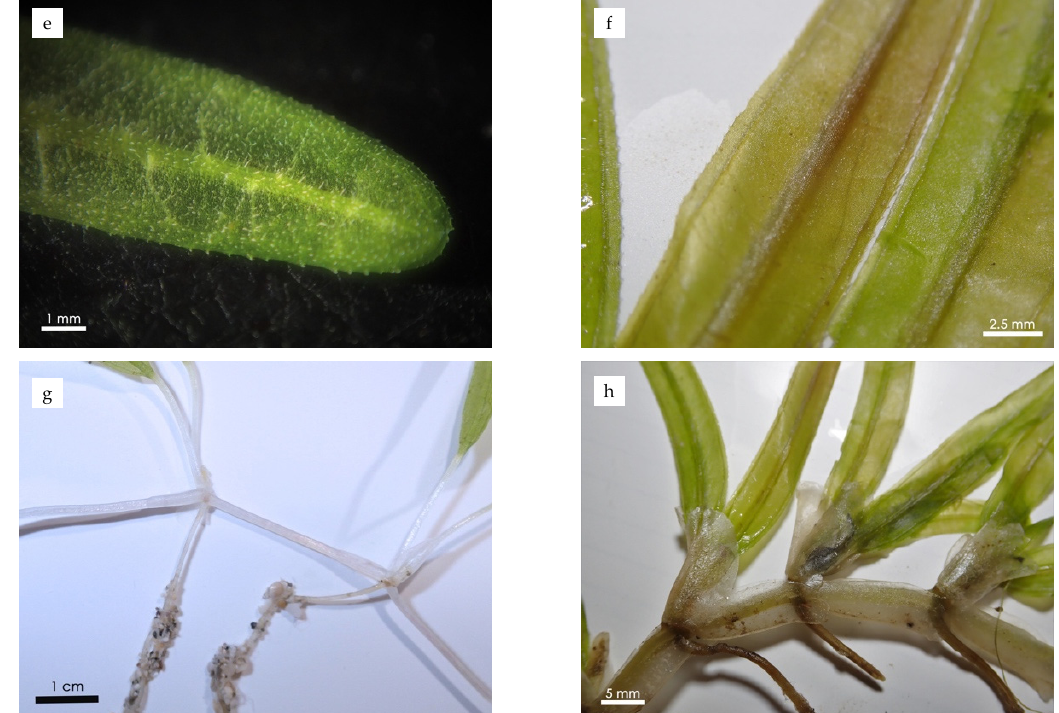
Figure 1. ( a ) A portion of Halophila sp. plant with leaf blades, apical meristem, rhizome, and roots. Scale bar = 1 cm. ( b ) A portion of H. stipulacea plant with linear to oblong leaf blades, scales (black arrows), rhizome, and roots. Scale bar = 1.5 cm. ( c ) Halophila sp. leaf blade with unbranched cross- veins, intra-marginal veins, and midrib. Scale bar = 5 mm. ( d ) H. stipulacea leaf blade showing serrated margin, numerous branched cross-veins (white arrows), intra-marginal vein, and midrib. Scale bar = 2.5 mm. ( e ) Close-up of Halophila sp. leaf blade showing serrate margin and a dense covering of minute unicellular hairs on the surface. Scale bar = 1 mm. ( f ) Close-up of H. stipulacea leaf blade with lack of minute hair and finely serrated margins. Scale bar = 2.5 mm. ( g ) Halophila sp. without persistent scales. Scale bar = 1 cm. ( h ) H. stipulacea showing large, persistent, transparent scales sheathing the petioles of leaf pairs. Scale bar = 5 mm. The photos from the left column are originally from Gerakaris et al., (2020) [39].